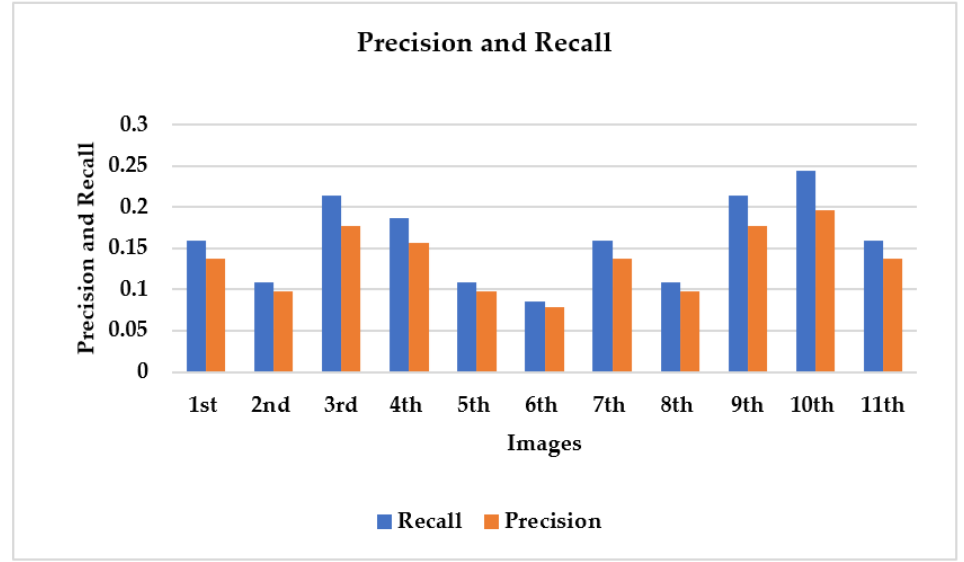
Figure 28. Precision and recall computed for TU Berlin dataset based on InfoGAN.